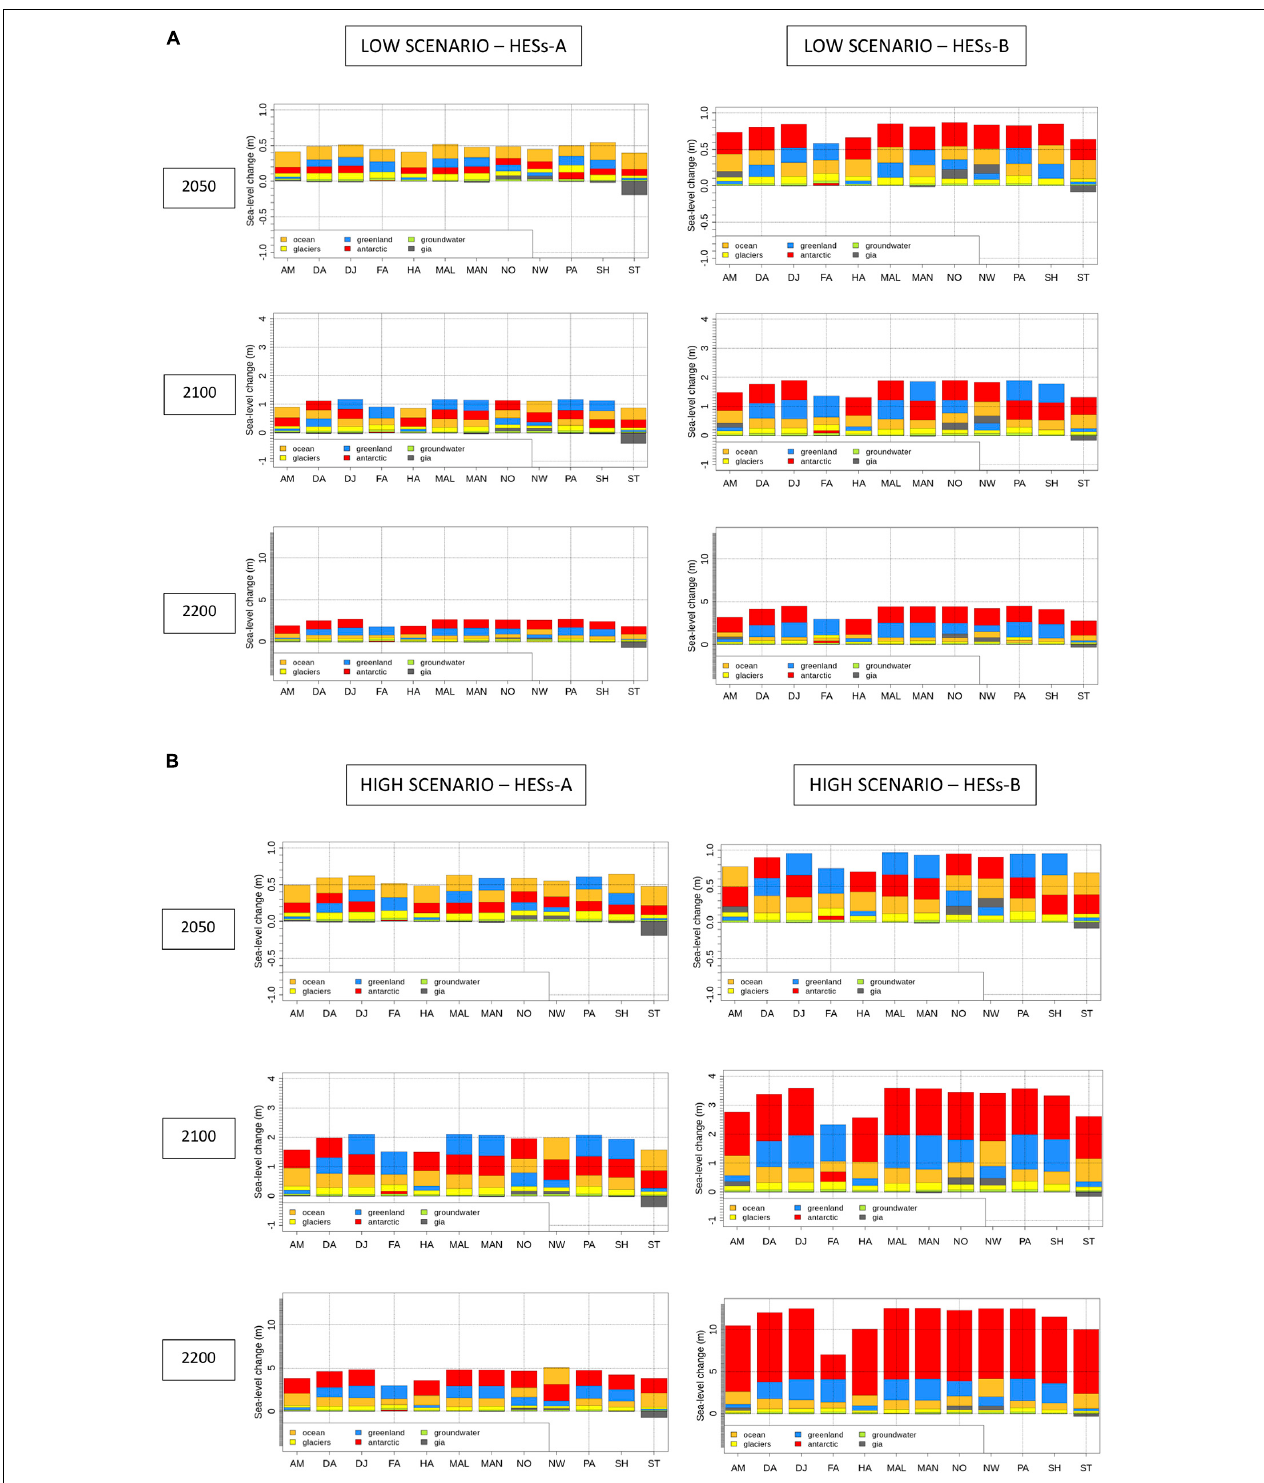
FIGURE 6 | Contributions to sea-level change (m) by 2050, 2100, and 2200 relative to 1986–2005 for both HESs in (A) the low emission scenario at left(right) and (B) the high emission scenario. The X -axis indicates the twelve selected sites: AM (AMsterdam), DA (DAkar), DJ (DJakarta), FA (The FAlkland Islands), HA (Le HAvre), MAL (The MALdives), MAN (MANila), NO (New Orleans), NW (New York), PA (PApeete), SH (SHanghai), and ST (STockholm). The top of each bar of the histogram indicates the regional SLR for each site including all the contributions (see Table 3 for detailed values), while each color bar indicates the relative contribution to sea-level change for each component and are sorted in ascending order. Note that the boundaries of the Y -axis are different for each time horizon.